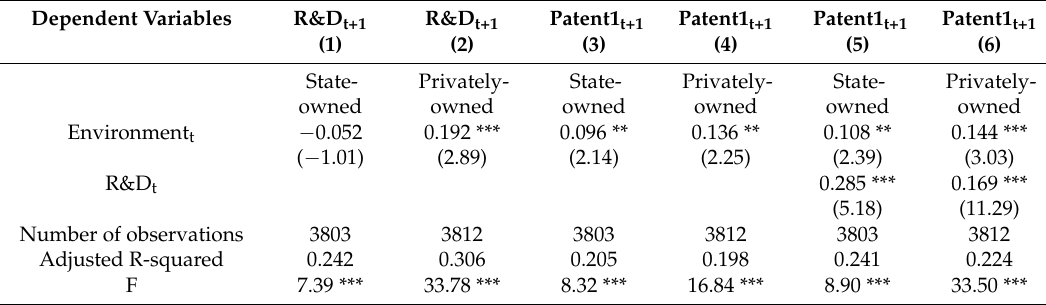
Table 5. The moderating effect of ownership type.